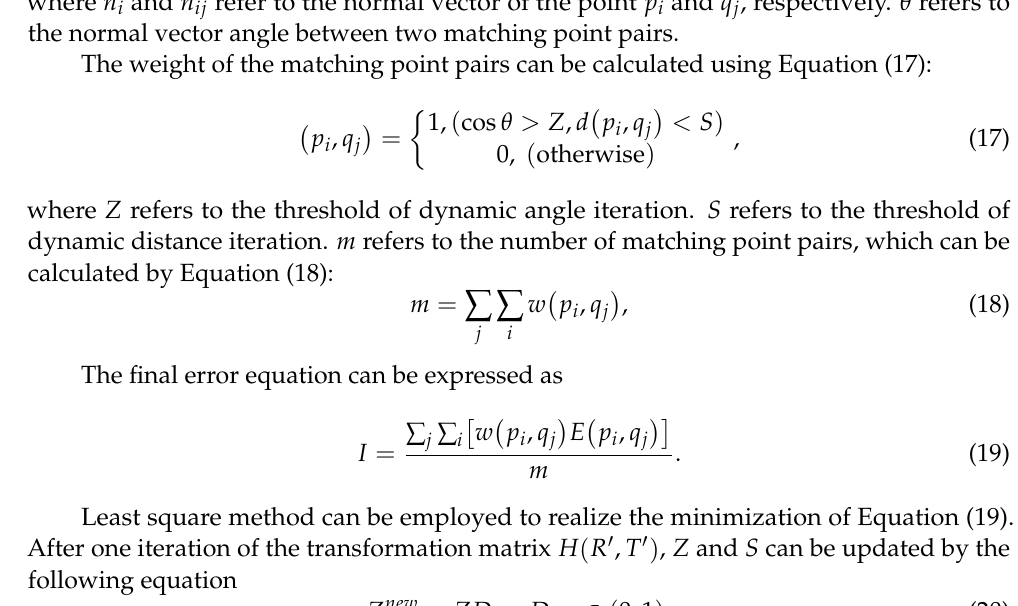
Figure 9. Point cloud iterative matching process: Q is iterated to position Q (cid:48) with a smaller offset angle and distance from P .